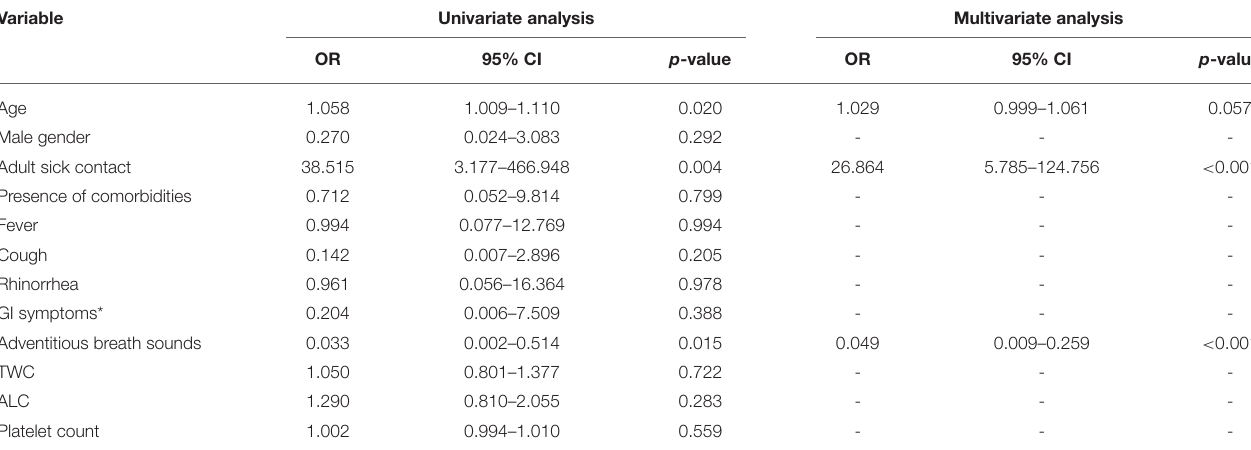
TABLE 3 | Multivariate analysis of independent risk factors for differentiating severe COVID-19 from other viral Pneumonia.